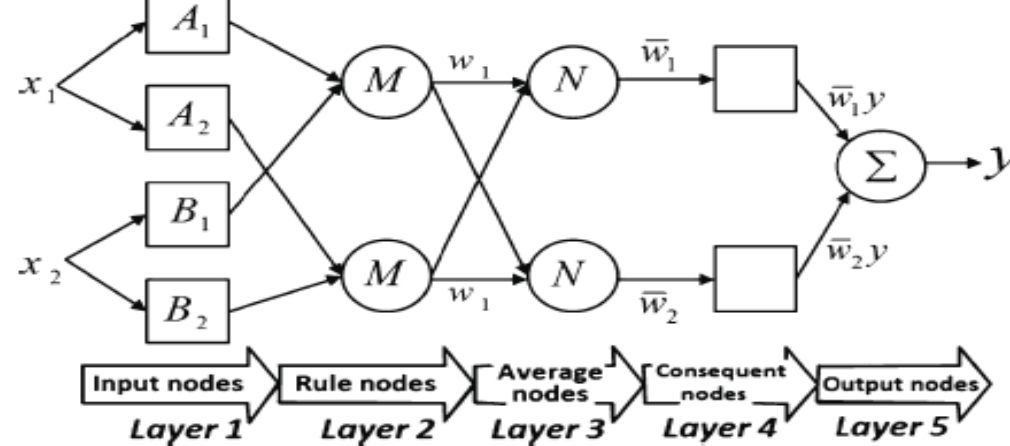
Figure 1. Architecture of the adaptive network-based fuzzy interface system (ANFIS) [27].